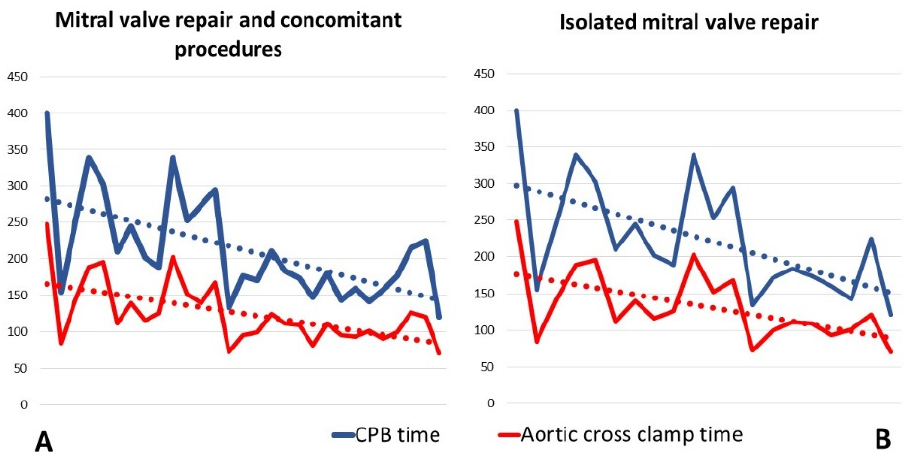
Figure 3. Operative times.These graphics show the progressive reduction of CPB- and cross clamp-time from the be- ginning or our robotic mitral valve experience. ( A ) Operative times of entire mitral valve repair cohort, including all 29 patients treated with mitral valve repair and concomitant procedures; ( B ) Operative times of isolated mitral valve repair procedures. For this graphic, all patients with mitral valve repair and concomitant procedures were excluded. CPB: cardiopulmonary